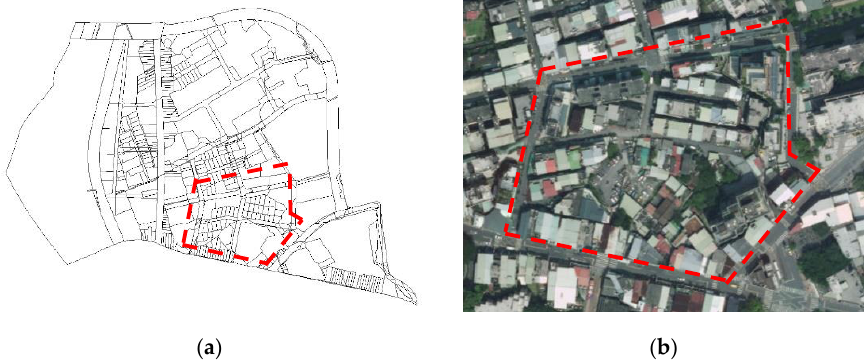
Figure 14. The test area of an urban cadastral detail survey. ( a ) Cadastral map. ( b ) Aerial image.